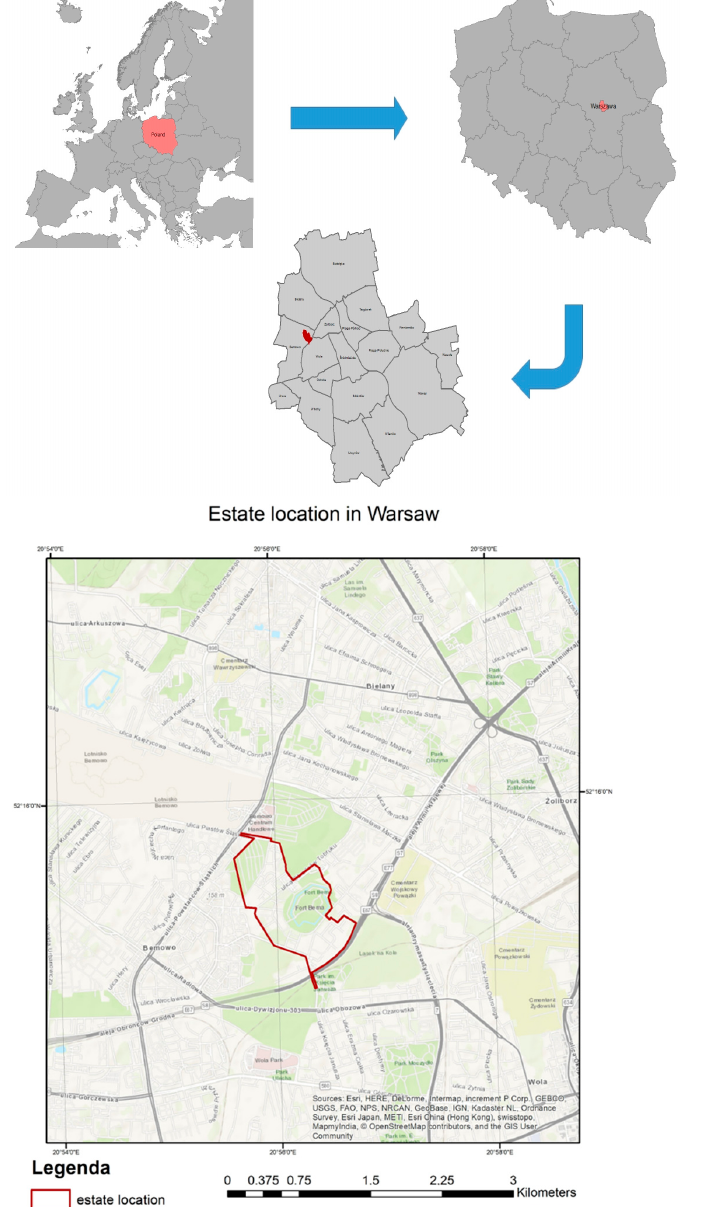
Figure 2. Site of Fort Bema in the Bemowo district of Warsaw, Poland (source: own elaboration).